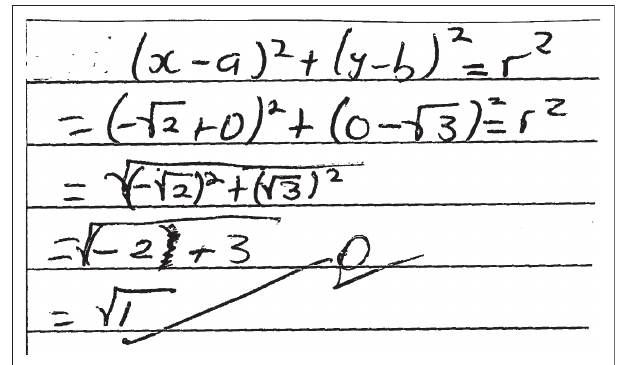
FIGURE 2: A formula not related to the question that was asked